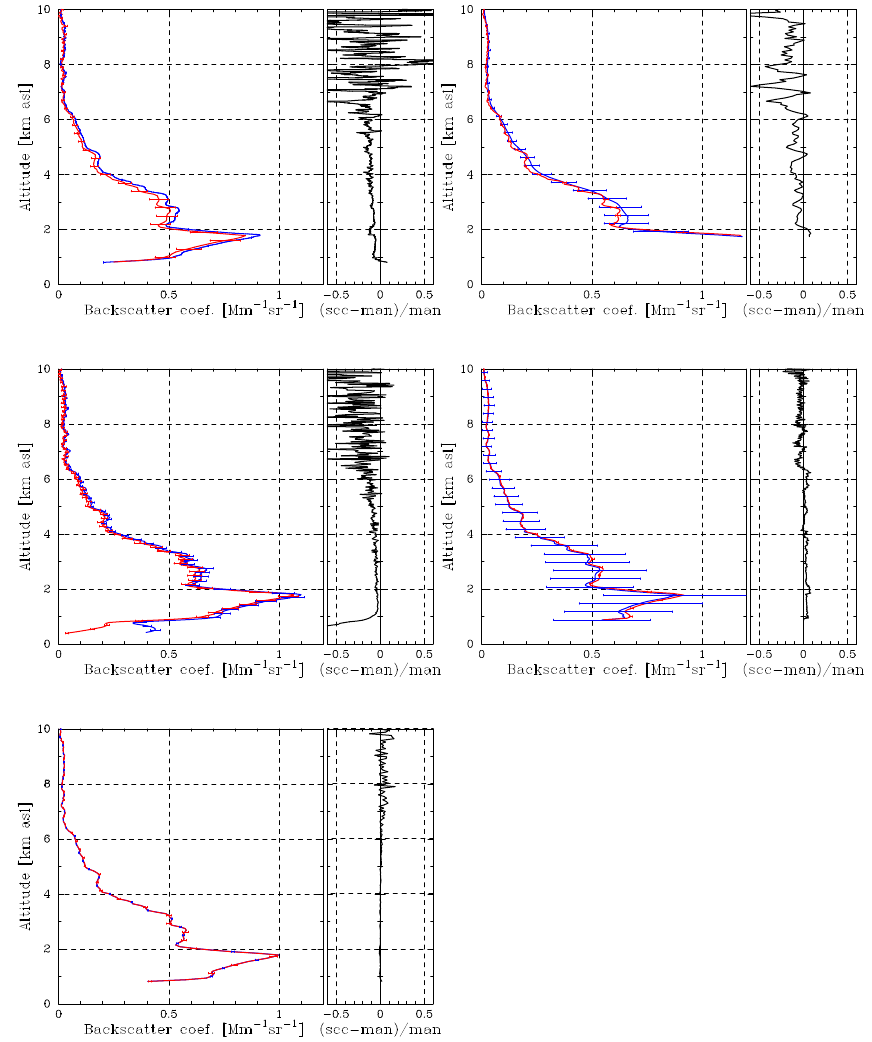
Figure 4. Comparison of backscatter coefficient profiles at 1064nm derived with the iterative method for five lidar systems participating in the EARLI09 inter-comparison campaign. All profiles refer to the measurement session taken from 21:00 to 23:00UT on 25 May 2009. The profiles in blue are the analyses provided by the originator of the data using his/her own analysis software. The profiles in red are the ones retrieved by the SCC. From left to right, upper panel: RALI, MARTHA; middle panel: Polly XT , MSTL-2; bottom panel: